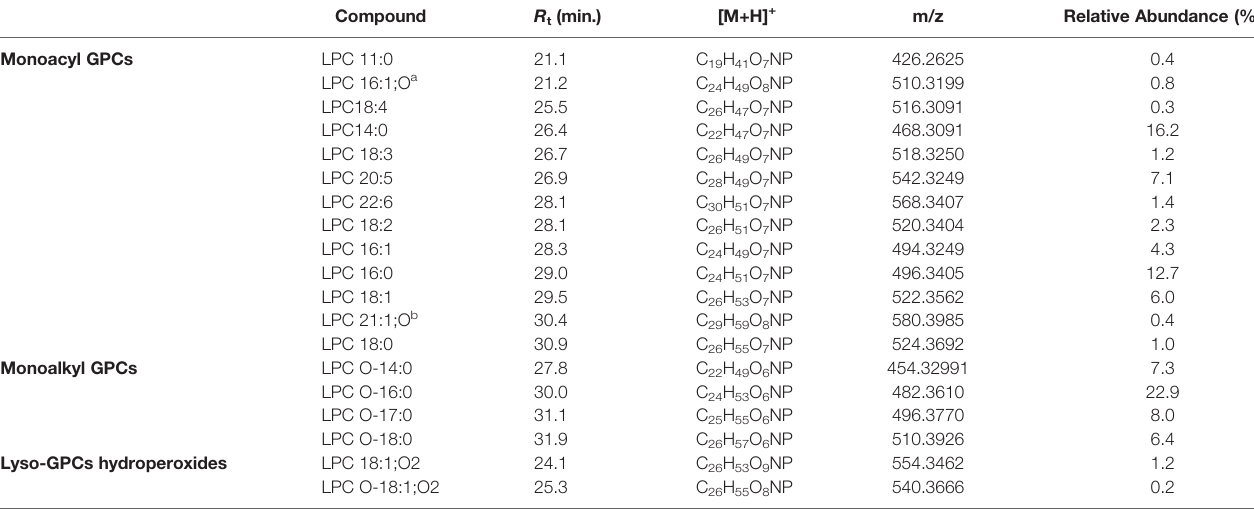
TABLE 2 | Lyso-glycerophosphocholines identi fi ed in the organic extract from Botrylloides niger . Compound R t (min.) [M+H] + m/z Relative Abundance (%)